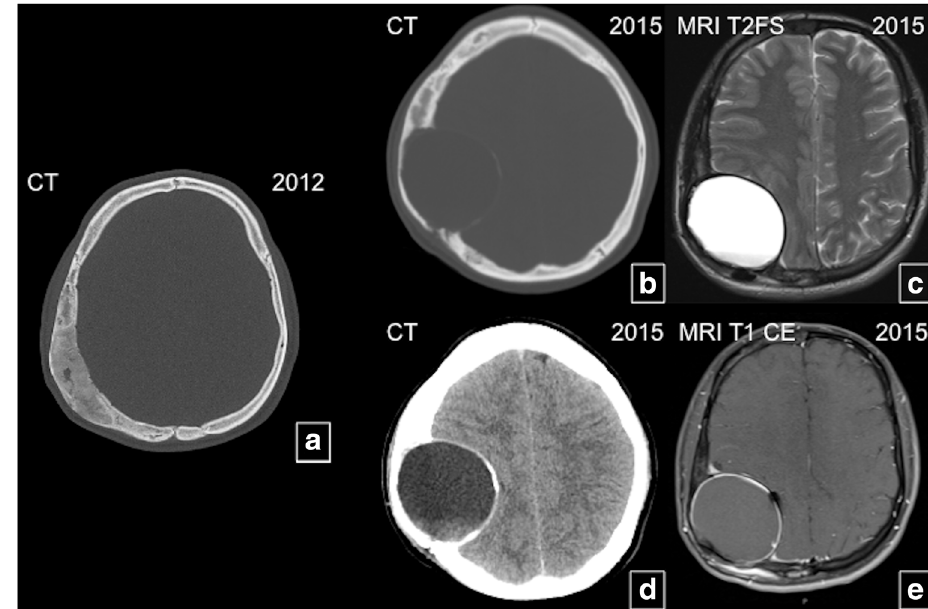
Fig. 20 Evaluation of hearing loss in craniofacial fibrous dysplasia (FD). a Extensive fibrous dysplasia (FD) involving petrous bones bilaterally; however, the internal auditory canals are patent ( green arrows ). T2 fat- saturated ( b ) and T1 contrast-enhanced ( c ) MRI demonstrate a large FD